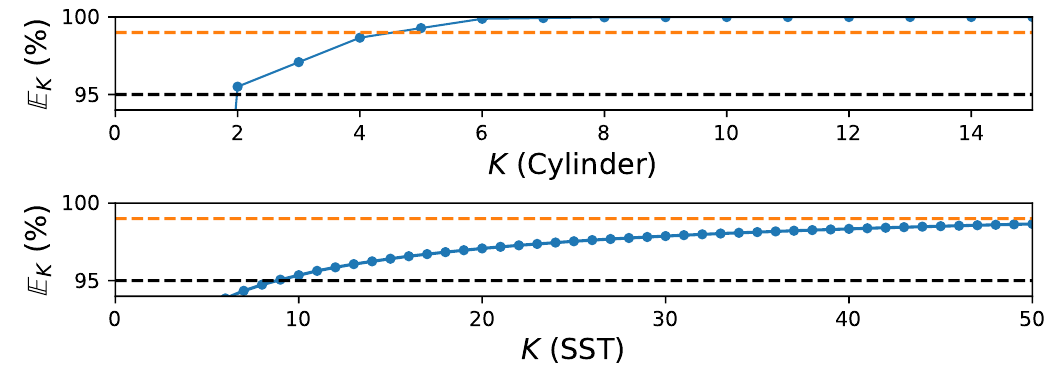
Figure 11. Schematic shows the cumulative energy capture corresponding to different system dimension, K (i.e., the number of POD modes), for cylinder flow at Re = 100 ( top ) and sea surface temperature (SST) data ( bottom